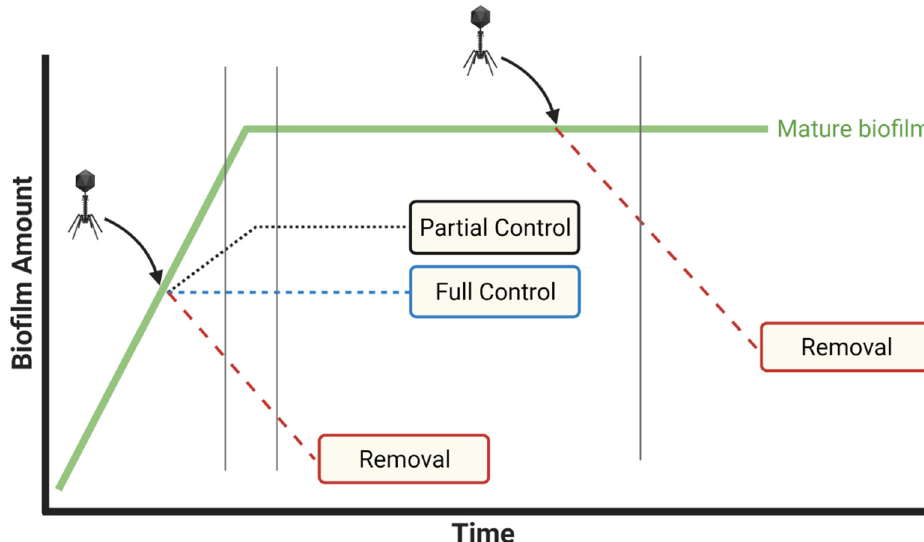
Figure 2. Control of biofilm growth vs. removal of existing biofilm. The extent of phage impact on biofilms can be contingent on when phages are added as well as what is used as a negative-treatment control. Toward illustration, two hypothetical experiments with different zero time points are presented: prior to biofilm maturation and after biofilm maturation (downward-pointing arrows). Mock treatment is shown as a solid-green curve ending in the “Mature biofilm” label. Negative controls consist of determinations of biofilm properties either at zero times (arrows) or post-treatment (corresponding to vertical gray lines). “Partial Control” indicates that biofilm growth might be possible even in phage presence, though less growth than with mock treatment. Created with BioRender.com.